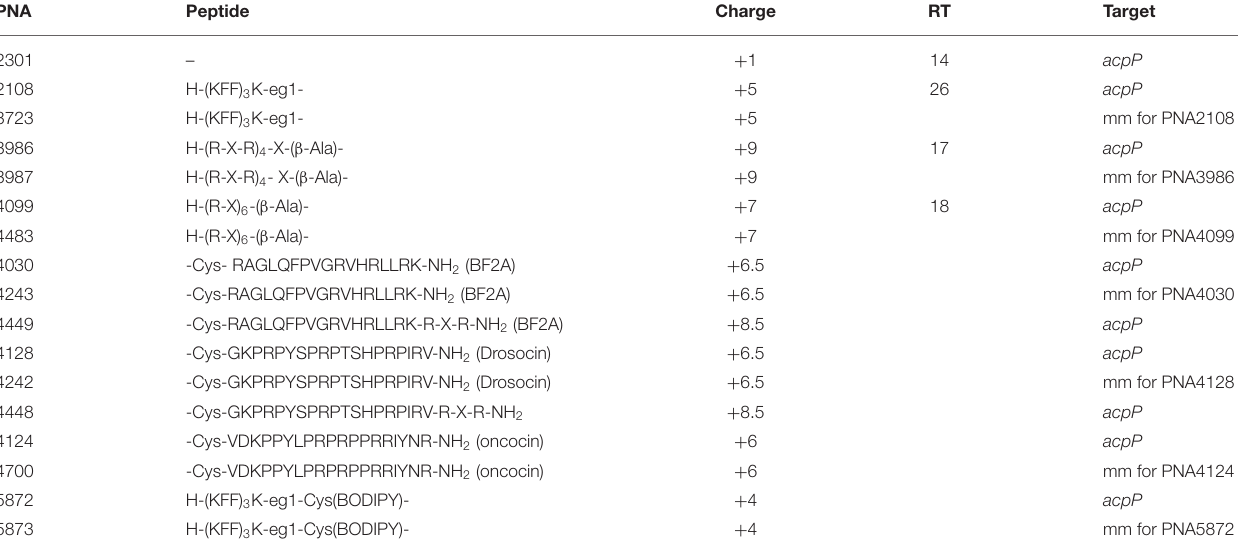
TABLE 1 | BPP-PNA conjugates (mm = mismatch)